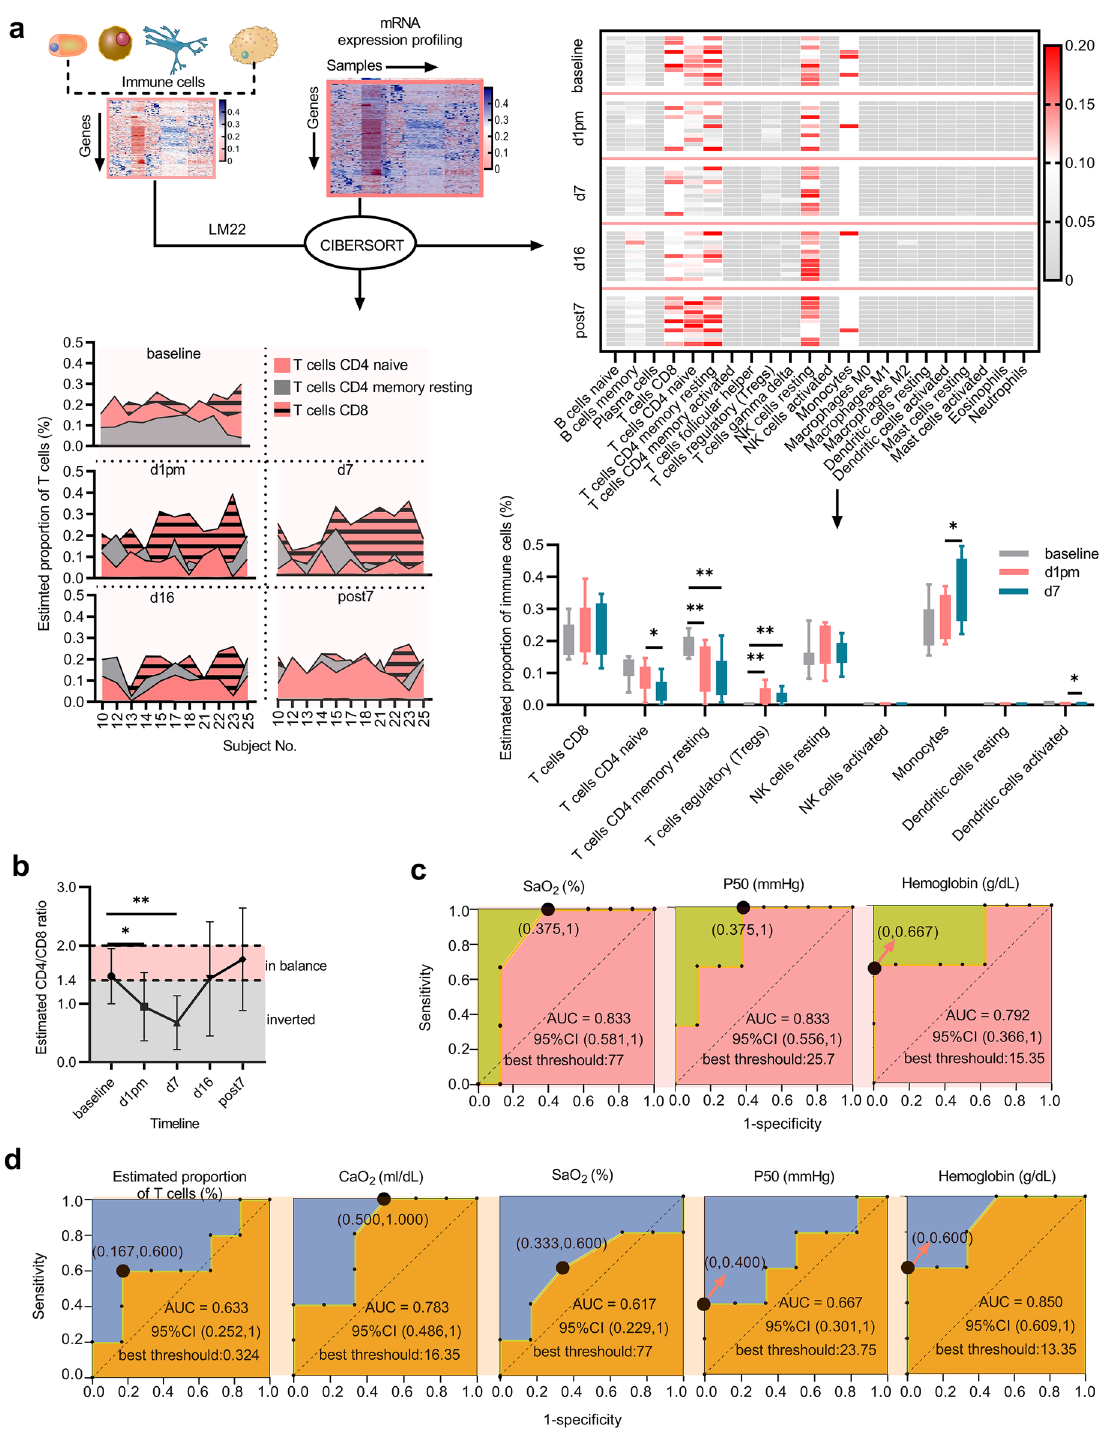
Figure 3. The potential risk factors for sAMS. ( a ) CIBERSORT algorithm coupled with LM22 revealed the timeline proportion of leukocytes in each subject. As indicated in the heatmap, resting T cells and NK cells were dominantly proportioned in subjects exposed to VLH. The proportion of CD4 T cells was predicted to be significantly decreased at d1pm and d7 compared with that at baseline. The bar chart indicates the changes in the average cell proportions across baseline, d1pm, and d7 (N = 11, paired t test, * P < 0.05, ** P < 0.01). The error bars indicate the 95% CI. The timeline changes in CD4 and CD8 T cells in each subject in the training cohort are displayed with the area chart. ( b ) The inverted CD4/CD8 ratio. The average estimated CD4/CD8 ratio decreased from baseline to d1pm and then increased from d7 to post7 (N = 11, paired t test, * P < 0.05, ** P < 0.01). ( c ) Binary classifiers of the CD4/CD8 ratio and the best thresholds. ( d ) Binary classifiers of sAMS and the best